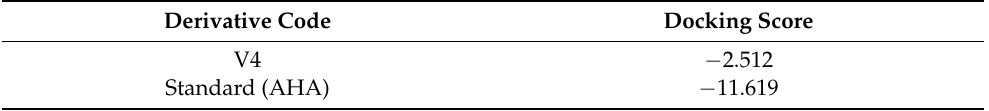
Table 7. Docking score of synthesized derivatives of2-(N-((2 (cid:48) -(2H-tetrazole-5-yl)-[1,1 (cid:48) -biphenyl]-4yl)- methyl)-pentanamido)-3-methyl butanoic